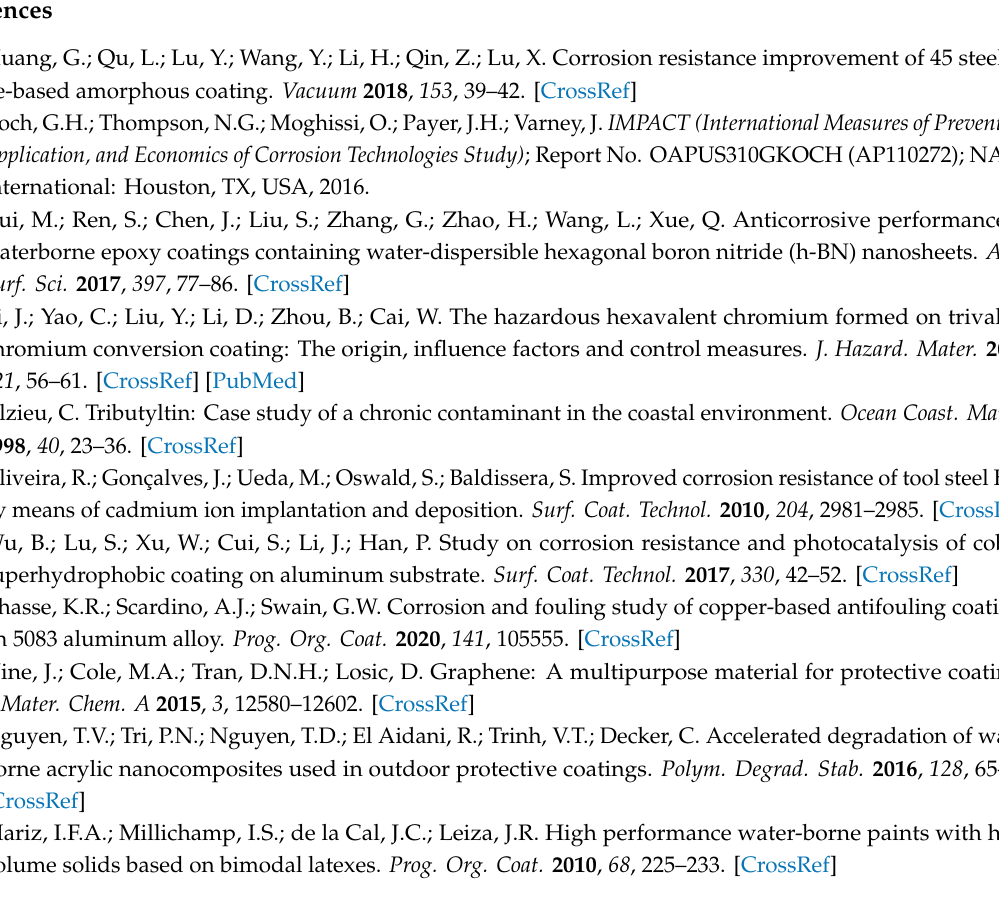
Table S1: Tafel parameters for SS-304, acrylic resin and nanostructured